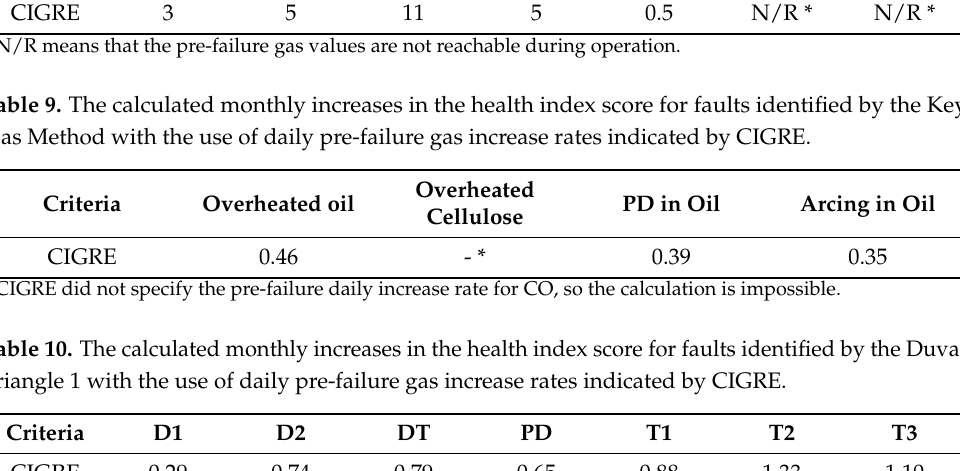
Figure 6. The major positive changes in the health index value between the successive measurements. To interpret the results, it is necessary to refer to the CIGRE analysis of the pre-failure states [30]. The pre-failure daily increases in individual gases are shown in Table 8, and the recalculated HI values for these thresholds considering the KGM and DTM 1 outputs can be found in Tables 9 and 10. Table 8. The pre-failure gas increase rate in ppm/day. Criteria